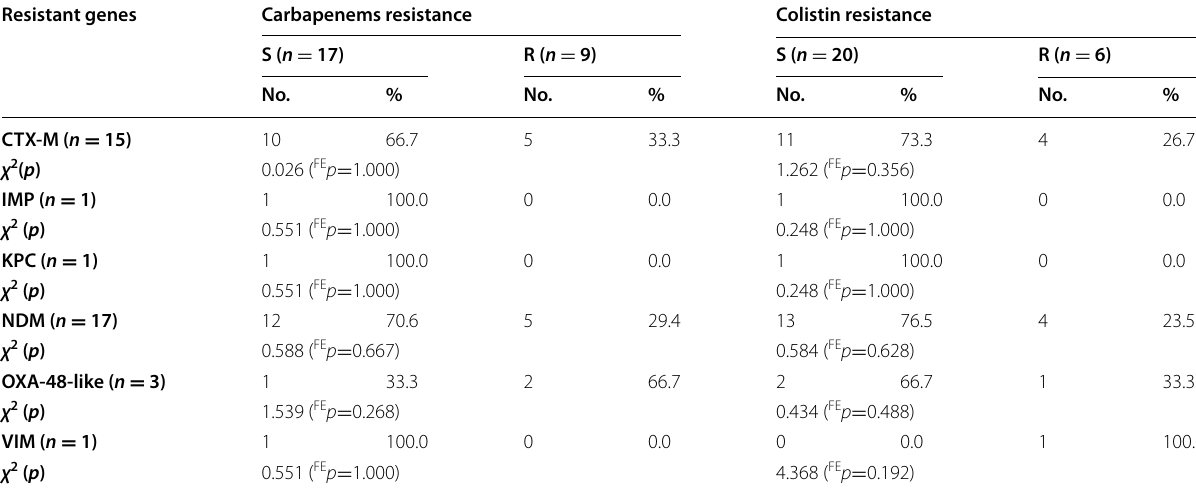
Table 3 The relation between the presence of antibiotic resistance genes by PCR and the results of disc diffusion antimicrobial susceptibility test for carbapenems and colistin by standard microbiological tests